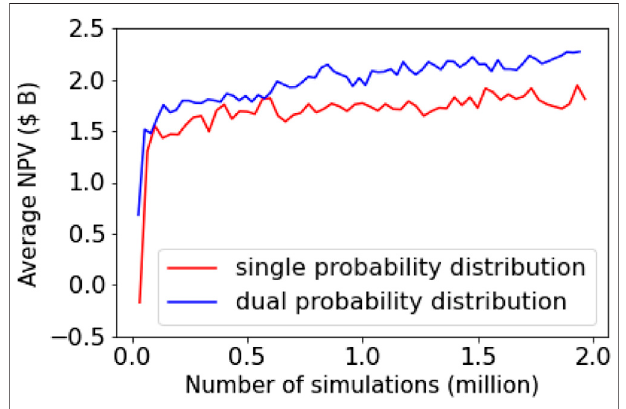
FIGURE 6 | Evolution of the average NPV for the single and dual-action probability distributions.